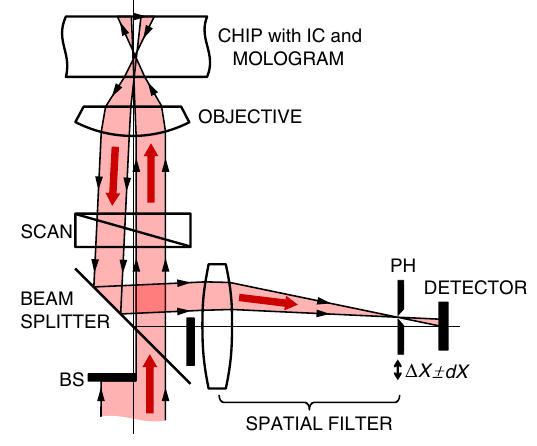
FIG. 5. Readout of the mologram through a bifocal laser- scanning microscope: The PH in front of the detector is adjusted to the optically conjugated position to F 0 ; adjustment of the PH to the optically conjugated position F 0 makes the modified confocal laser-scanning microscope “ bifocal.